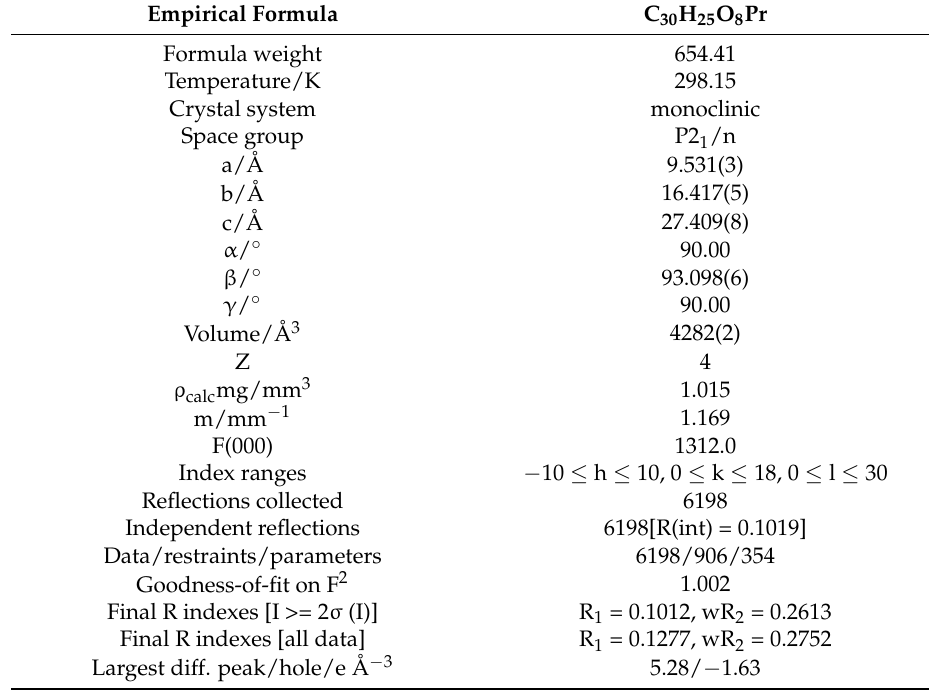
Table 1. Crystal data for complex 1